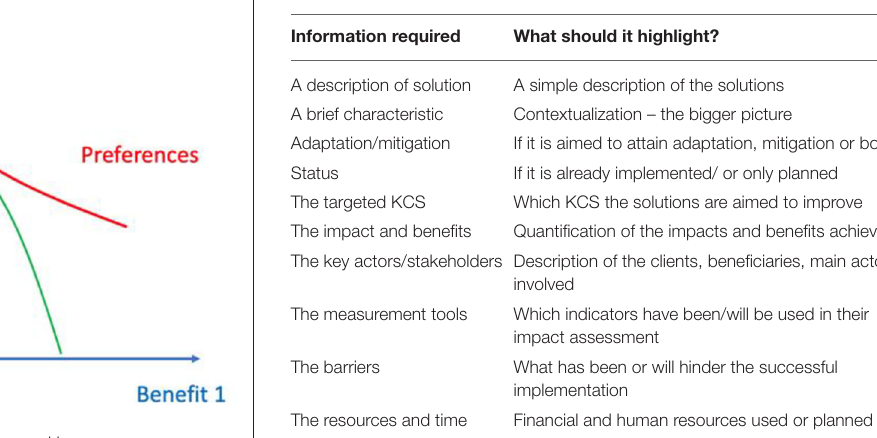
TABLE 1 | Summary information on the possible